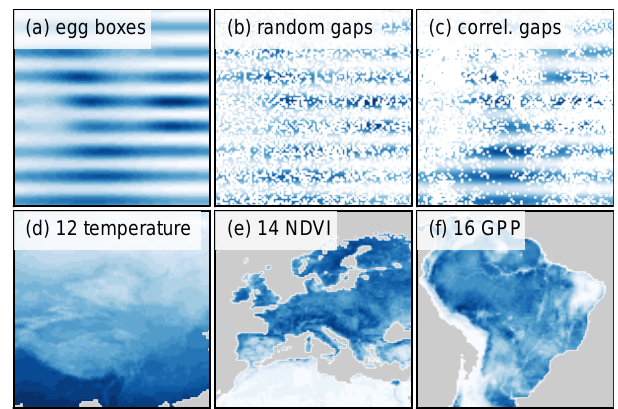
Fig. 3. Datasets and gap scenarios used for testing the gapfill- ing method. Artificial data (egg boxes, panels a – c ) and real-world datasets ( d – e ). Panel (b) and (c) show 50% of gaps for random gaps ( b , scenario 1 and 2) and spatiotemporally correlated gaps ( c , sce- nario 3 and 4). Scenario 3 gap positions were also used for the real- world test datasets. The ocean masks shown in (d) – (f) were also used for each individual real-world dataset and the egg boxes sets containing oceans (scenario 2a-c and 4a-c). Shadings of blue denote the actual value with light blue for the minimum and dark blue for the maximum of the respective variable range. See also Fig. 4 for a visualisation of the temporal structure of the